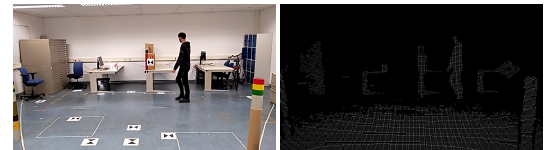
Figure 3. The RGB (left) and depth (right) data captured by ego pedestrian in the interaction space.